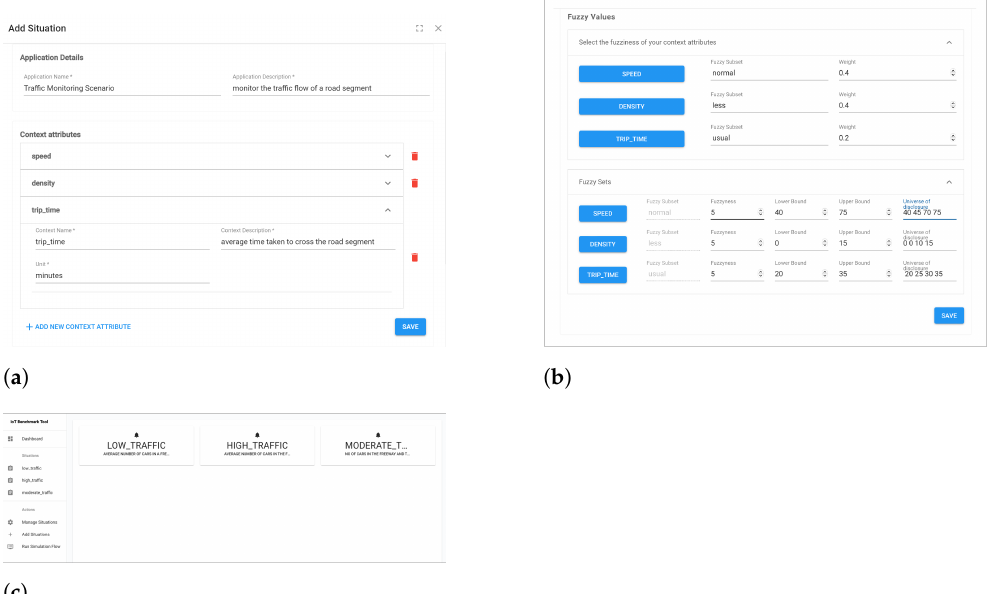
Figure 12. Snippets of the user interface to register situations and perform simulations: ( a ) register application details, ( b ) contextual information for registering situations, ( c ) dashboard view of registered